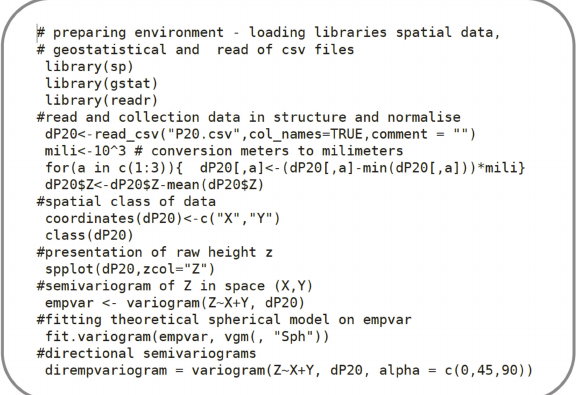
Figure 10. Algorithm No. 1 in R language. Data collection and semivariogram fitting to a sample surface (# starts description